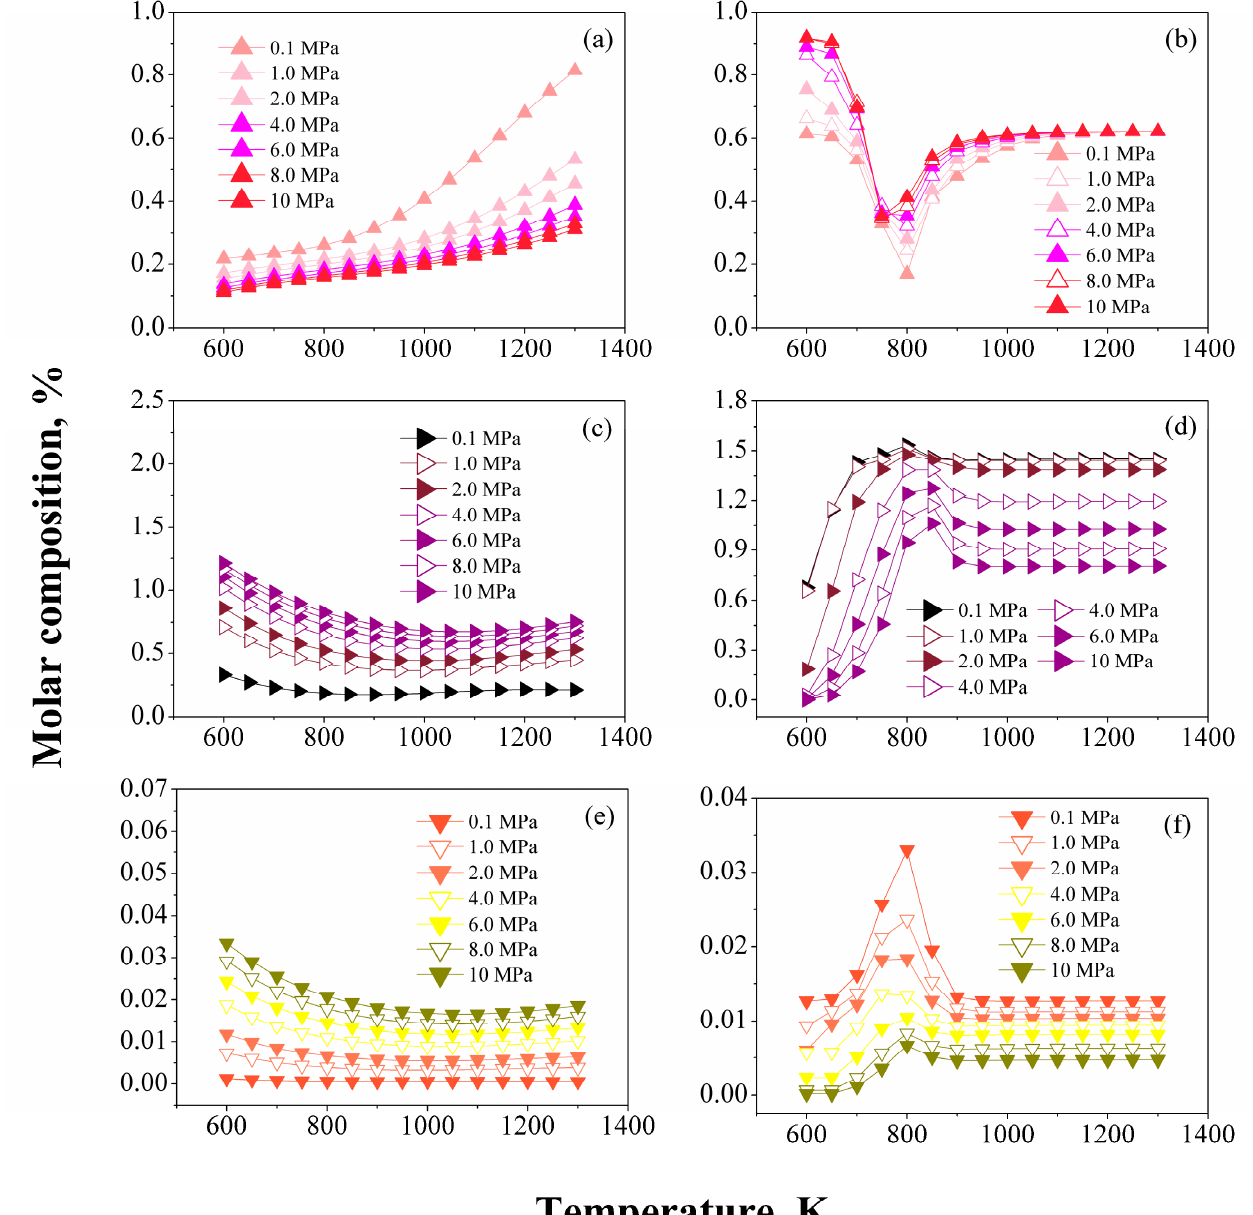
Figure 7. Effect of pressure on aromatics molar composition (R = 9.4 H 2 /HC): ( a ), ( c ), ( e ) Equilibrium. ( b ), ( d ), ( f ) Catalytic. ( / ) C 6 Aromatics, ( / ) C 7 Aromatics, ( / ) C 8 Aromatics.